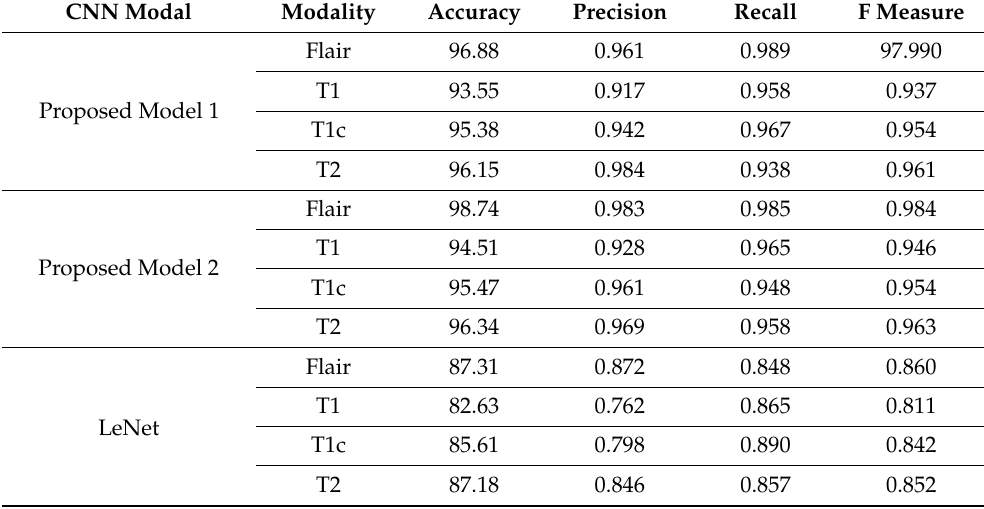
Table 7. Classification results using proposed CNN Models as classifier and comparison with existing CNN models for brain HGG MR